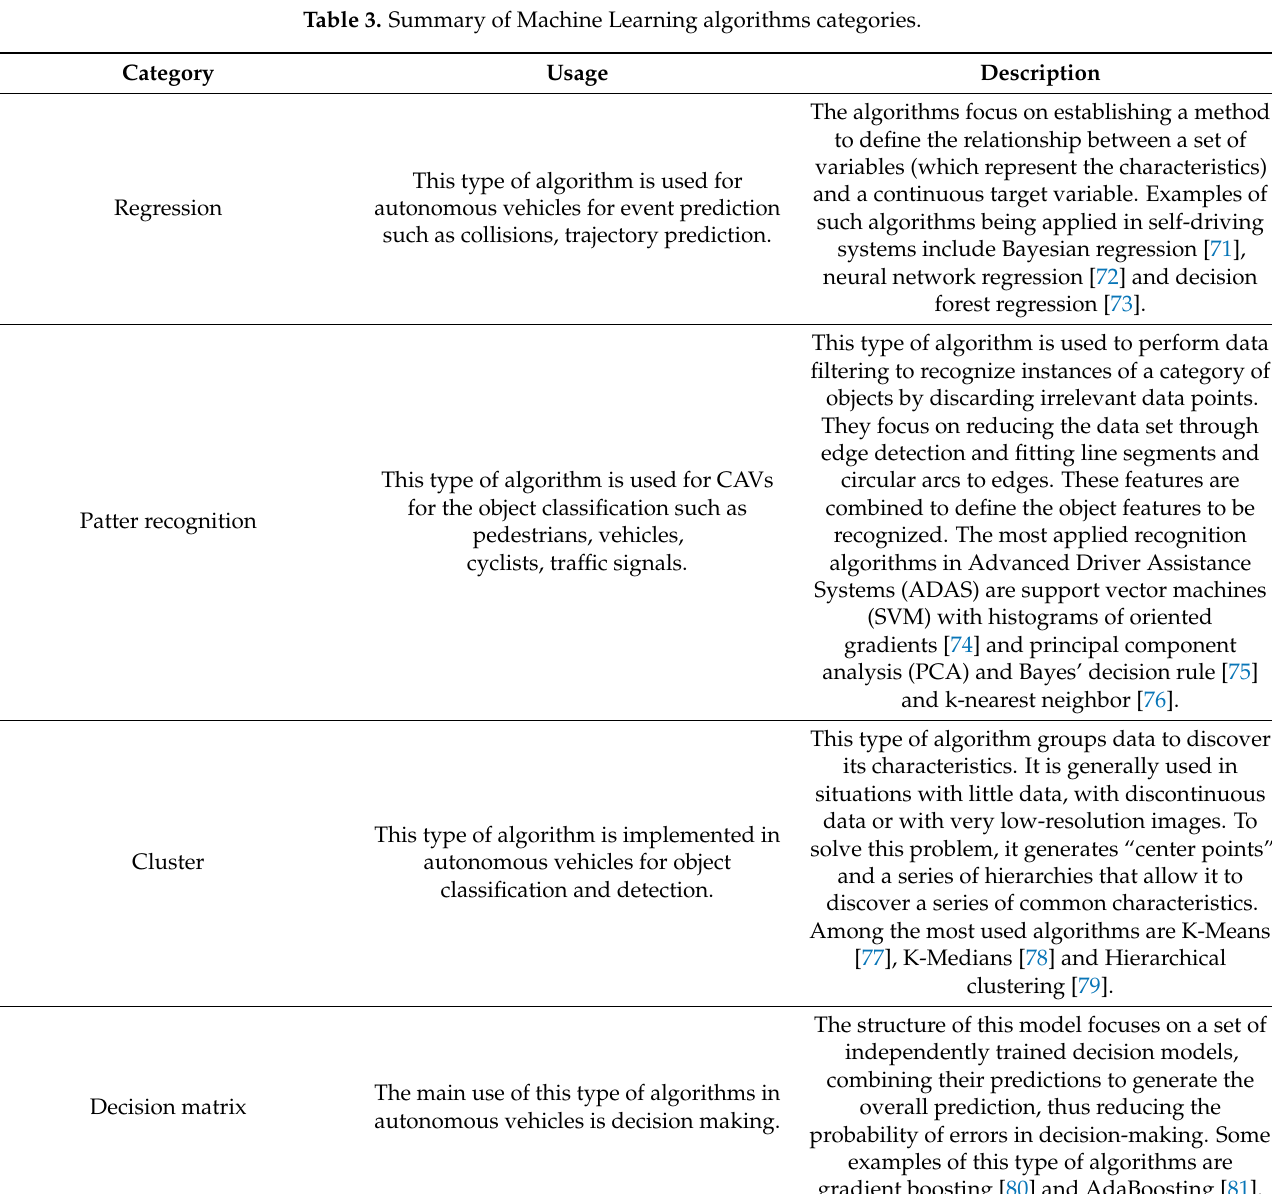
Table 3. Summary of Machine Learning algorithms